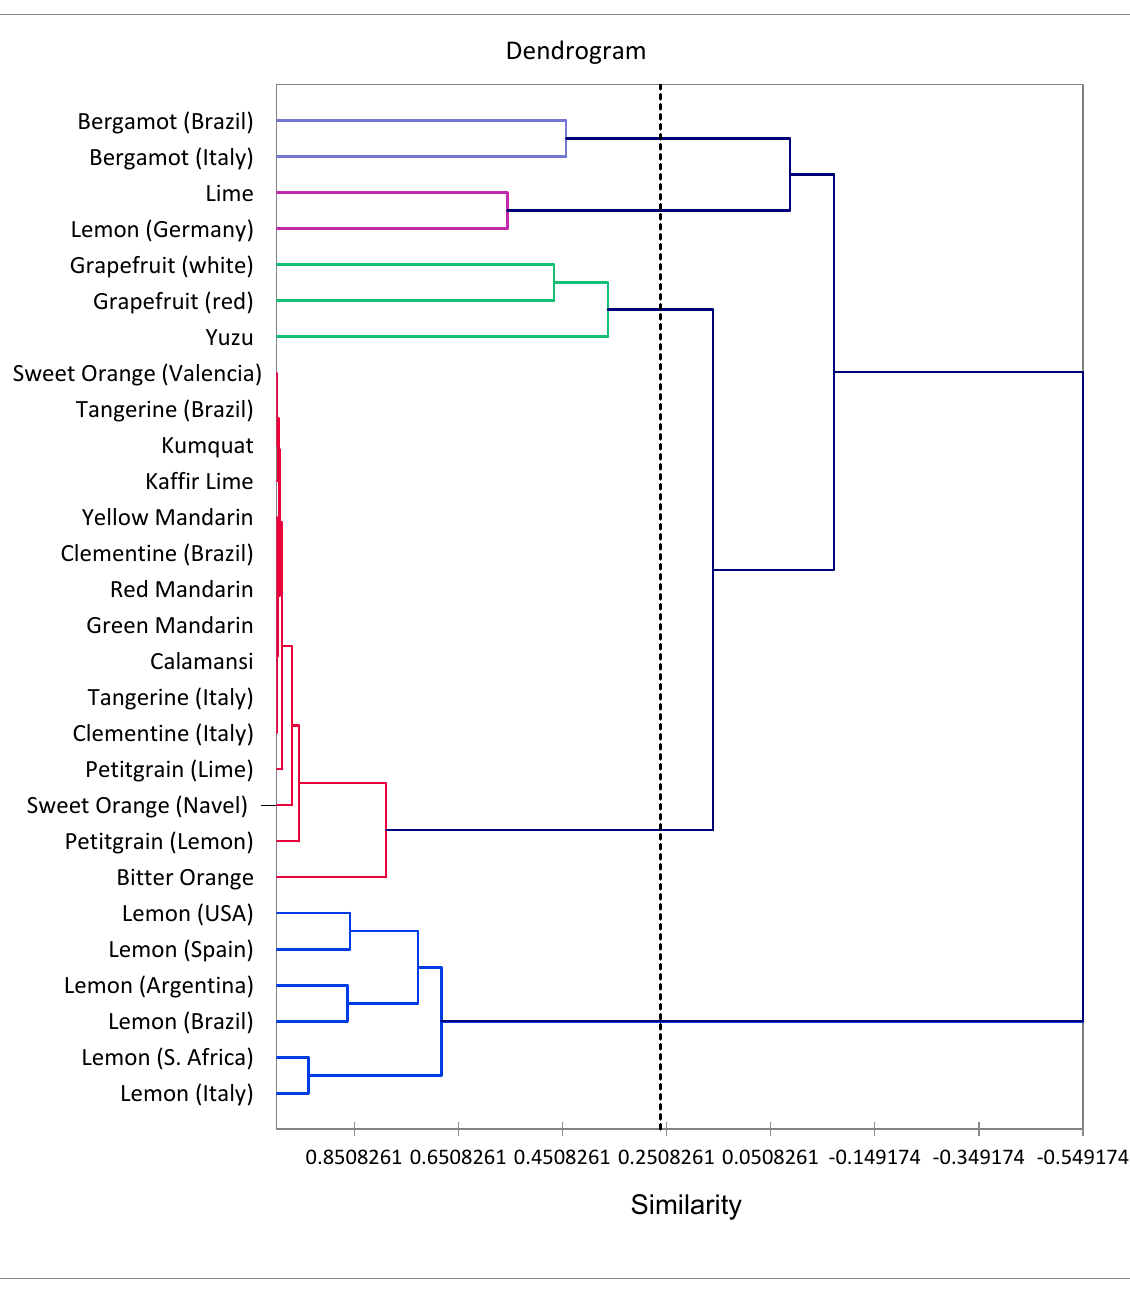
Figure 3. Dendrogram obtained by cluster analysis of the coumarin composition of Citrus essential oils, based on correlation and using the unweighted pair-group method with arithmetic average (UPGMA).